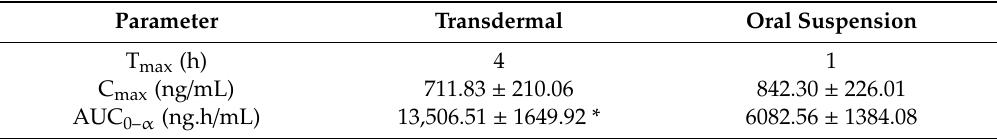
Figure 6. Plasma profiles of pioglitazone from transdermal Duro-Tak 87-2516 pioglitazone (6% w / w ) patch with propylene glycol and oral administration (4 mg / kg). All values are mean ± SD ( n = 6). Table 4. Pharmacokinetic parameters of pioglitazone in plasma following transdermal and oral administration in rats. T max , time of maximum concentration; C max indicates maximum concentration; AUC 0– α , area under the plasma concentration-time